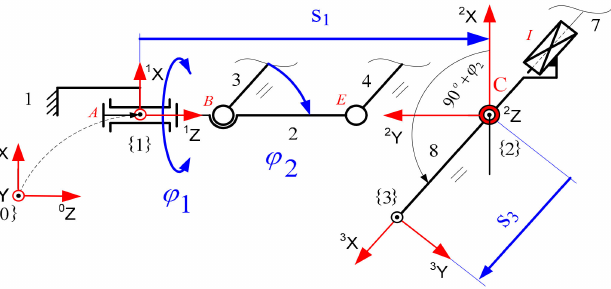
Figure 9. RCM mechanism with marked three joint variables (D-H variables) and a constant point C. The working space obtained by such a mechanism has the shape of a spherical sector. This is illustrated in Figure 10.